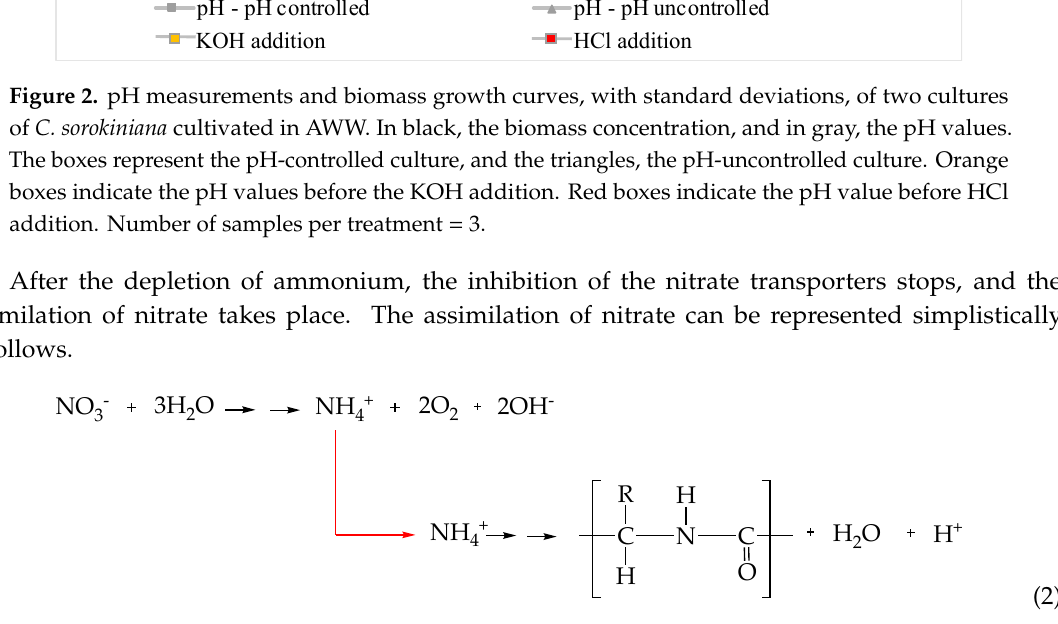
Figure 2. pH measurements and biomass growth curves, with standard deviations, of two cultures of C. sorokiniana cultivated in AWW. In black, the biomass concentration, and in gray, the pH values. The boxes represent the pH-controlled culture, and the triangles, the pH-uncontrolled culture. Orange boxes indicate the pH values before the KOH addition. Red boxes indicate the pH value before HCl addition. Number of samples per treatment =